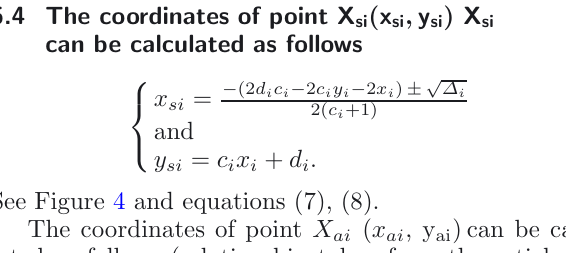
Fig. 2. Flow chart of the fuzzy logic estimator.